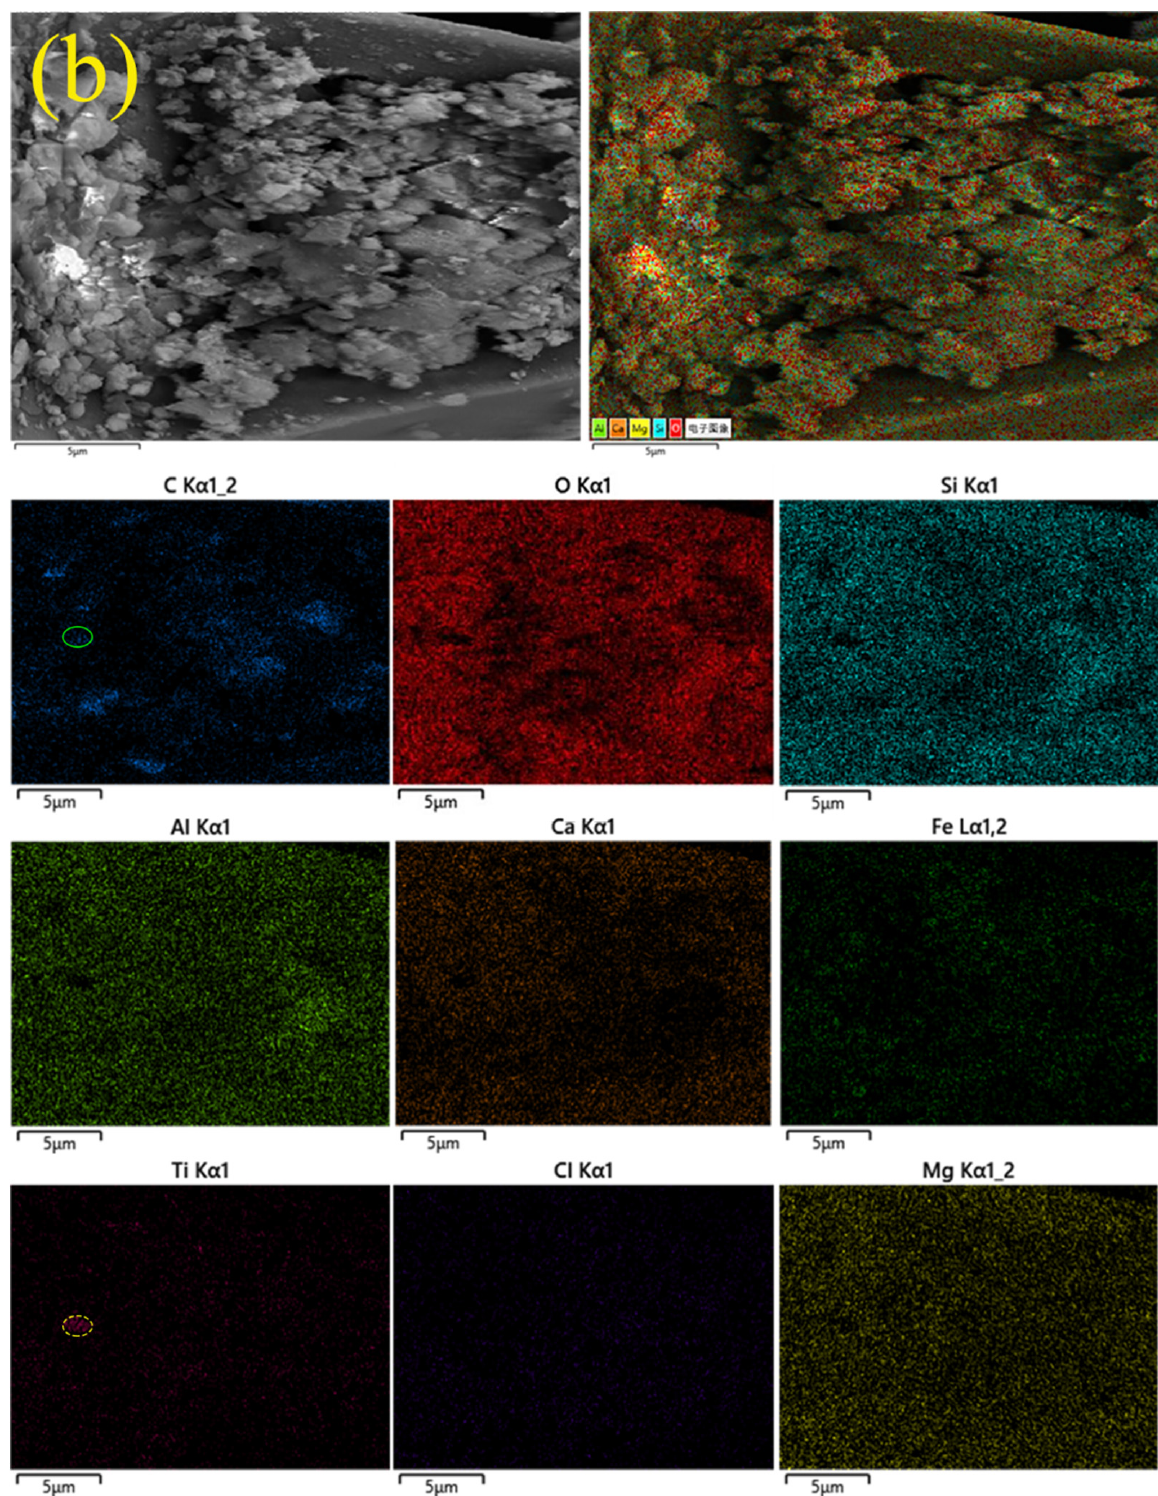
Figure 8. EDS photos and multiple element mappings of flotation products. ( a ) OPFC samples and ( b ) OPFT samples.